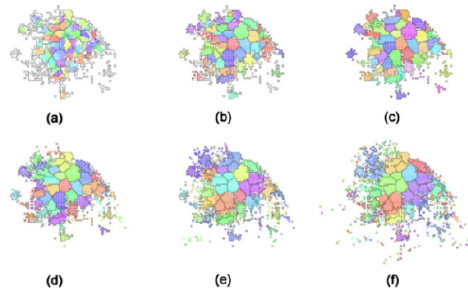
( c ) Figure 28. Dynamic trajectory-data visualization of high-dimensional projections from analyzing high-school contact patterns [76]: ( a , b ) temporal-information maps in different periods; and ( c ) horizontal axis map over a certain time. 4.3. Hierarchy 1.